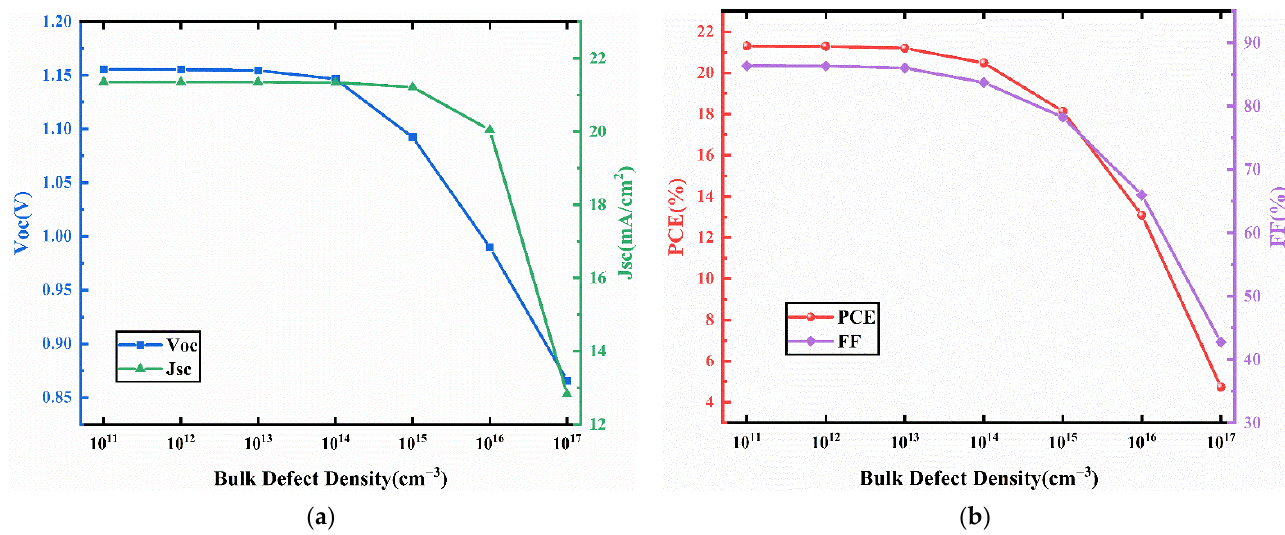
Figure 12. ( a ) Change in Voc and Jsc against absorber layer bulk defect density variation; ( b ) change in PCE and FF against absorber layer bulk defect density variation.